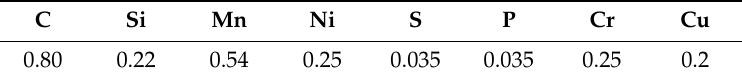
Table 1. Chemical compositions of carbon steel wires (wt.%).